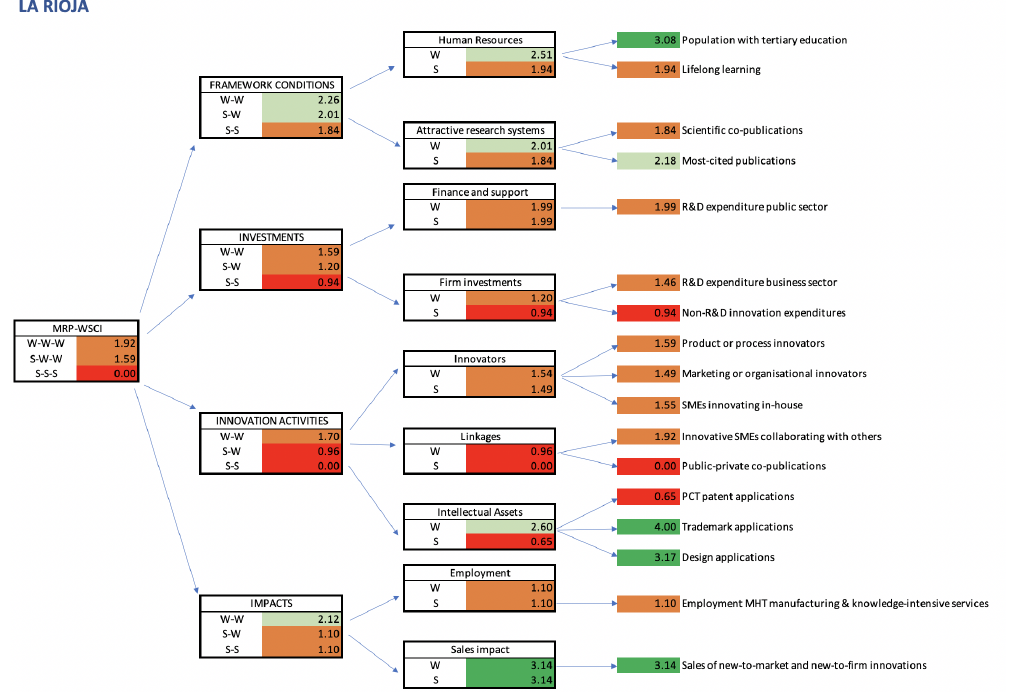
Figure 7. Light-Diagram for (ES23) La Rioja in 2019: EU reference levels. The values of the achievement functions and of each composite indicator are shown for every aggregation